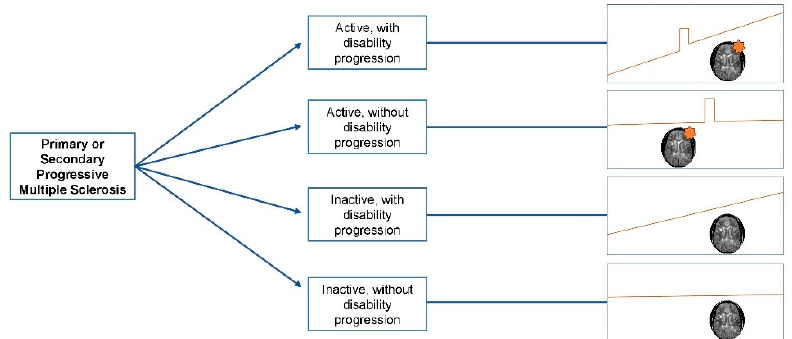
Figure 1. Clinical course of progressive multiple sclerosis. The orange star indicates the presence of radiological activity (new / enlarging T2 lesions or gadolinium enhancing